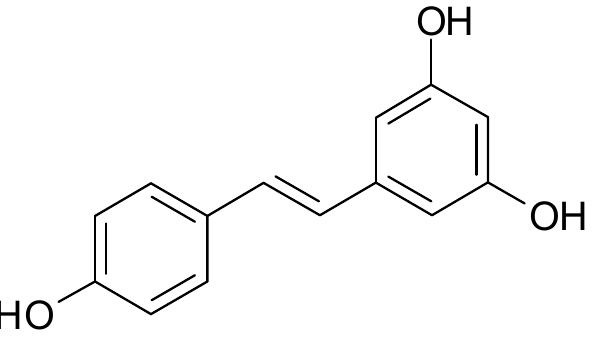
Figure 1. Stilbenic structure of t ‐ Resveratrol.